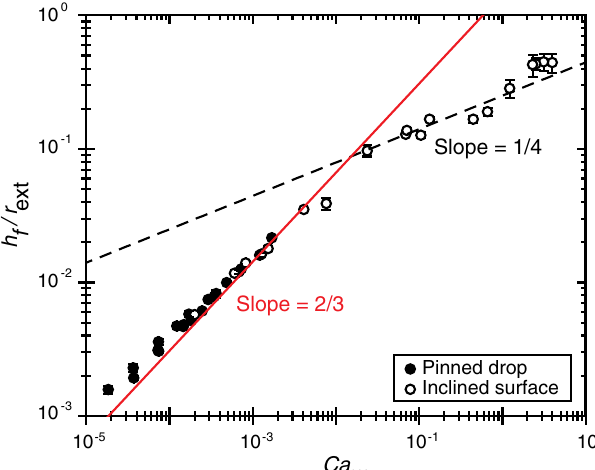
=r vs capillary number. The red line f ext ∼ Ca 2 = 3 using pinned =r f ext ∼ Ca 1 = 4 =r f ext